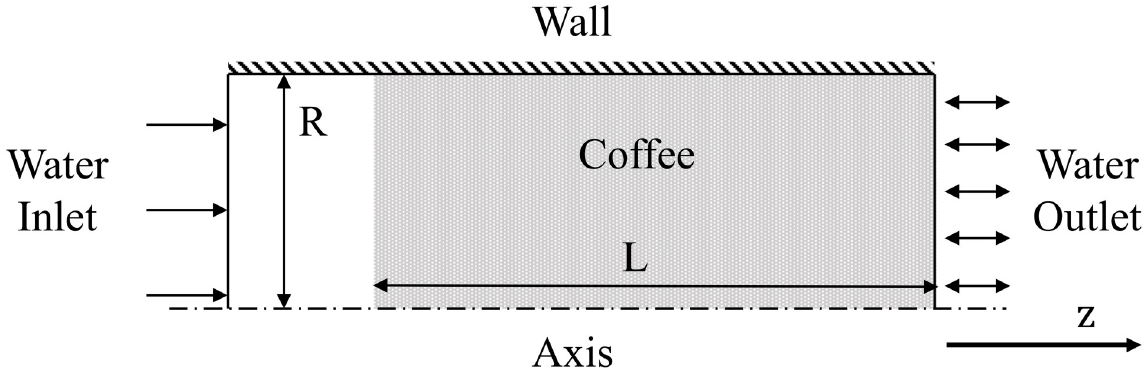
Fig 4. Cylindrical case computational domain. Cylindrical case computational domain with included boundary conditions.